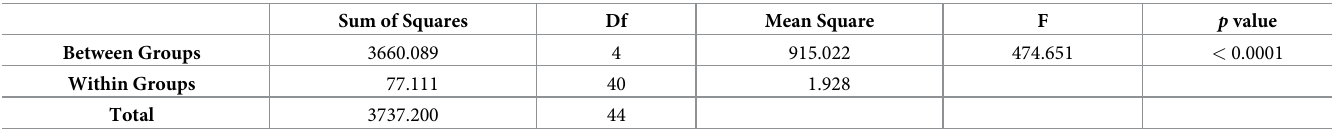
Table 2. Analysis of variance of the zones of inhibition of the various Eucalyptus grandis extracts and the control.